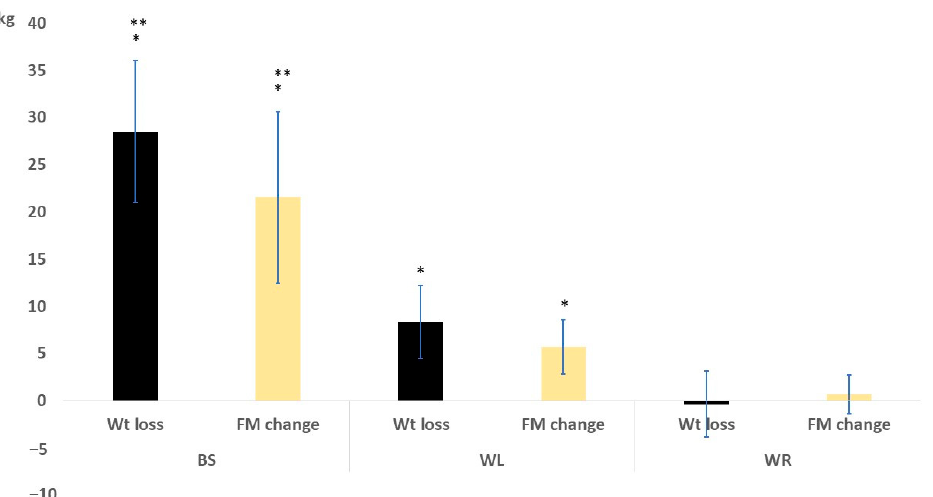
Figure 2. Weight and fat mass change after 6 months in the study groups. * means significant vs the WR group; ** means significant vs the WL group.